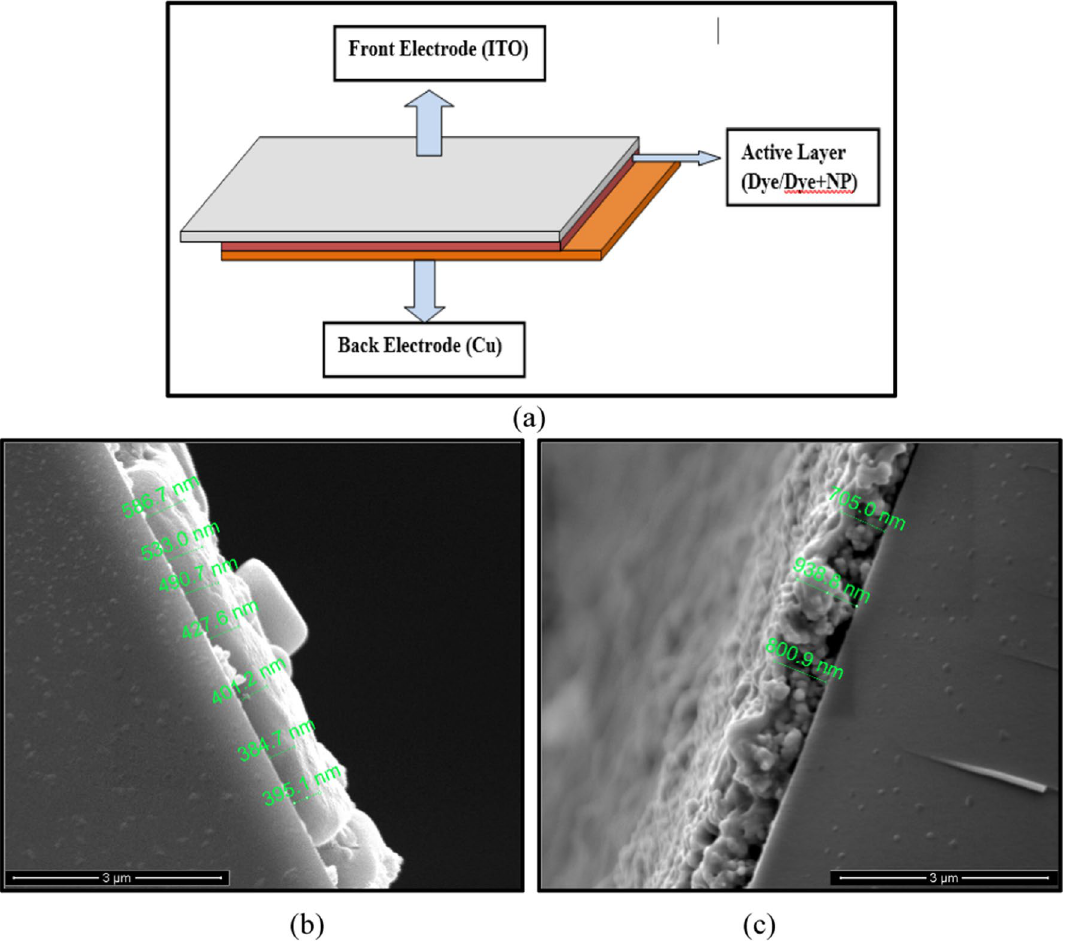
Fig.2 a Schematic cell diagram of ITO/Dye/Cu cell. b SEM image for the thickness of TZ dye thin film. c SEM image for the thickness of TZ dye with TiO nanoparticles thin 2